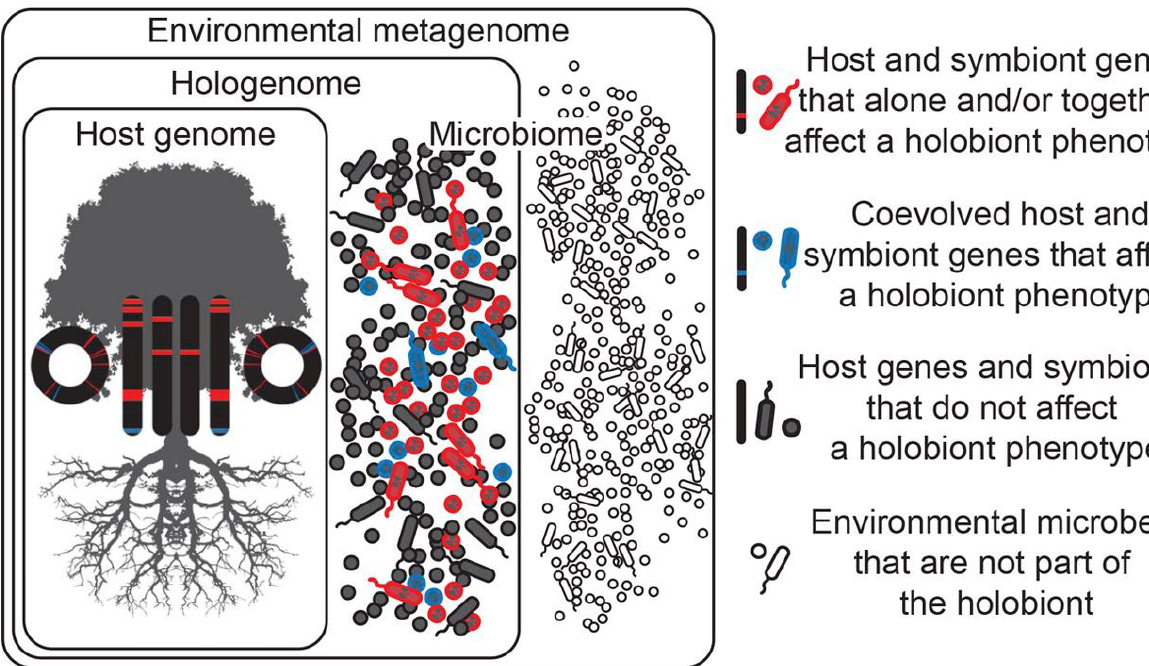
Figure 1. Level structure microbial communities from holobiont to environmental microbiota. Modified and here repro- duced with the permission of the copyright holder from Theis et al.